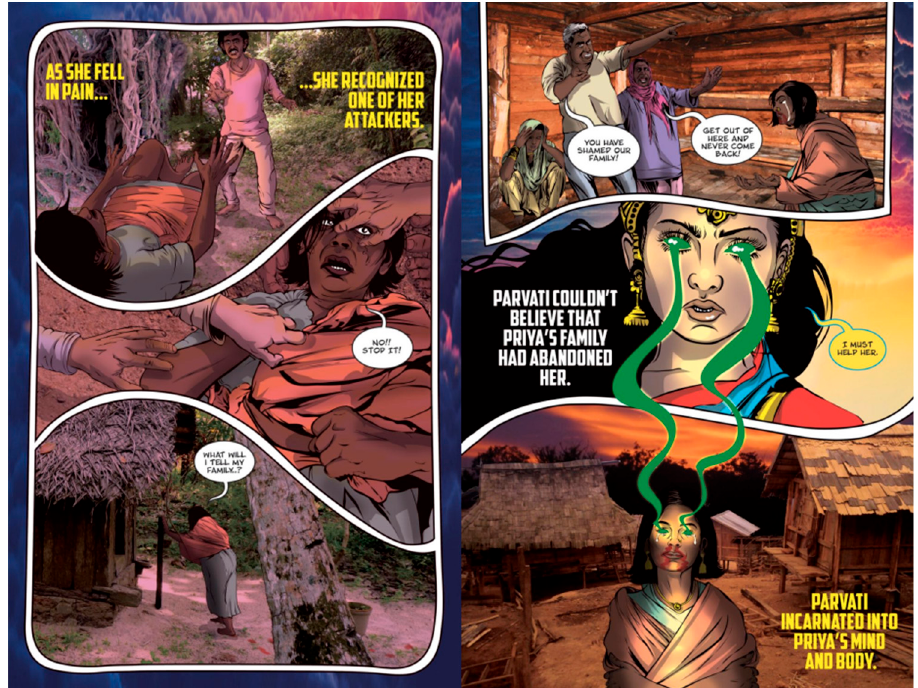
Figure 5. A panel from the Priya’s Shakti comic book in which Priya is assaulted and subsequently the goddess Parvati is incarnated into the girl’s mind and body. Image Courtesy: Ram Devineni.